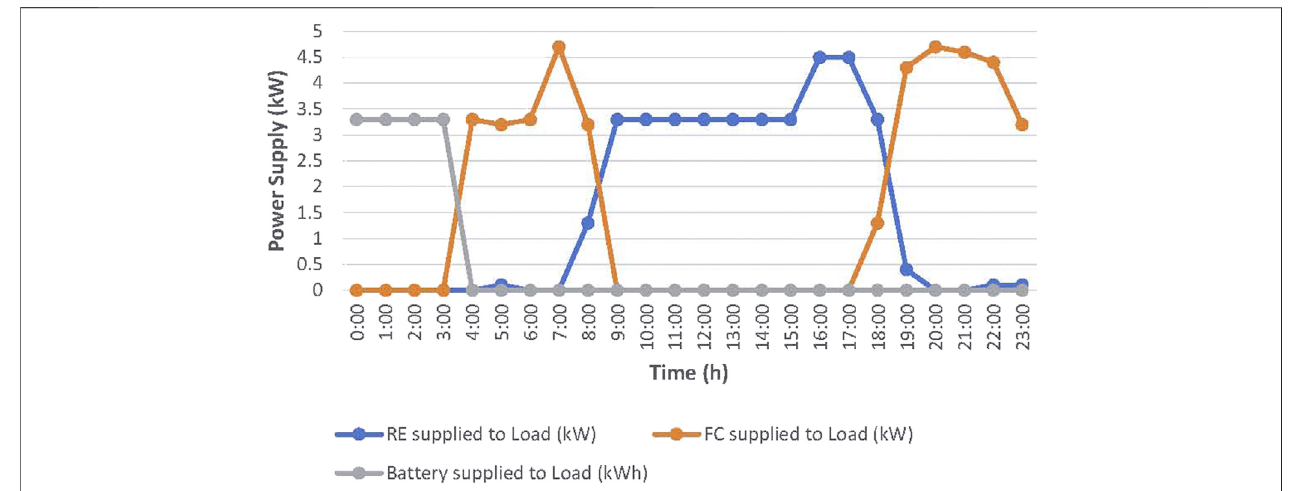
FIGURE 6 | Power Supplied by the Renewable Energy, Fuel Cell, and Battery to satisfy the Load Demand in Day 1